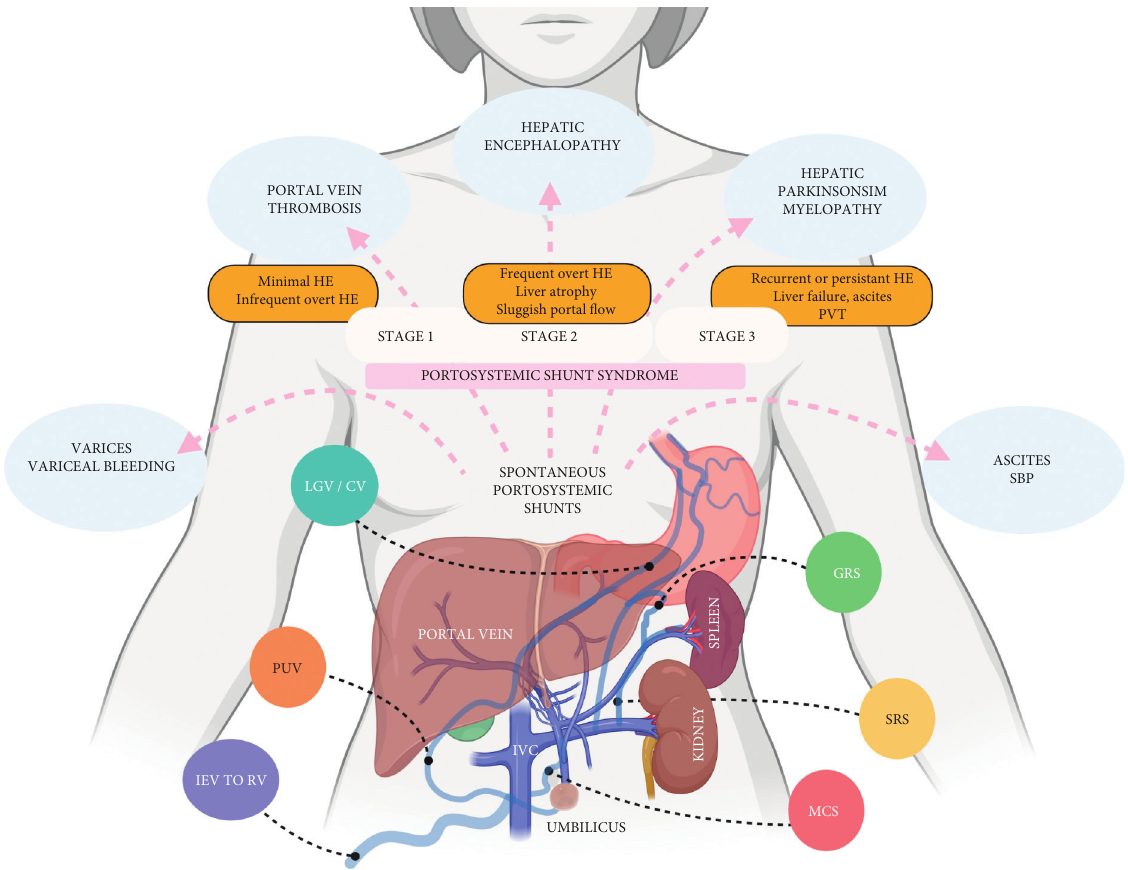
Figure 13: Schematic infographics showing the stages and impact of large spontaneous portosystemic shunts in patients with